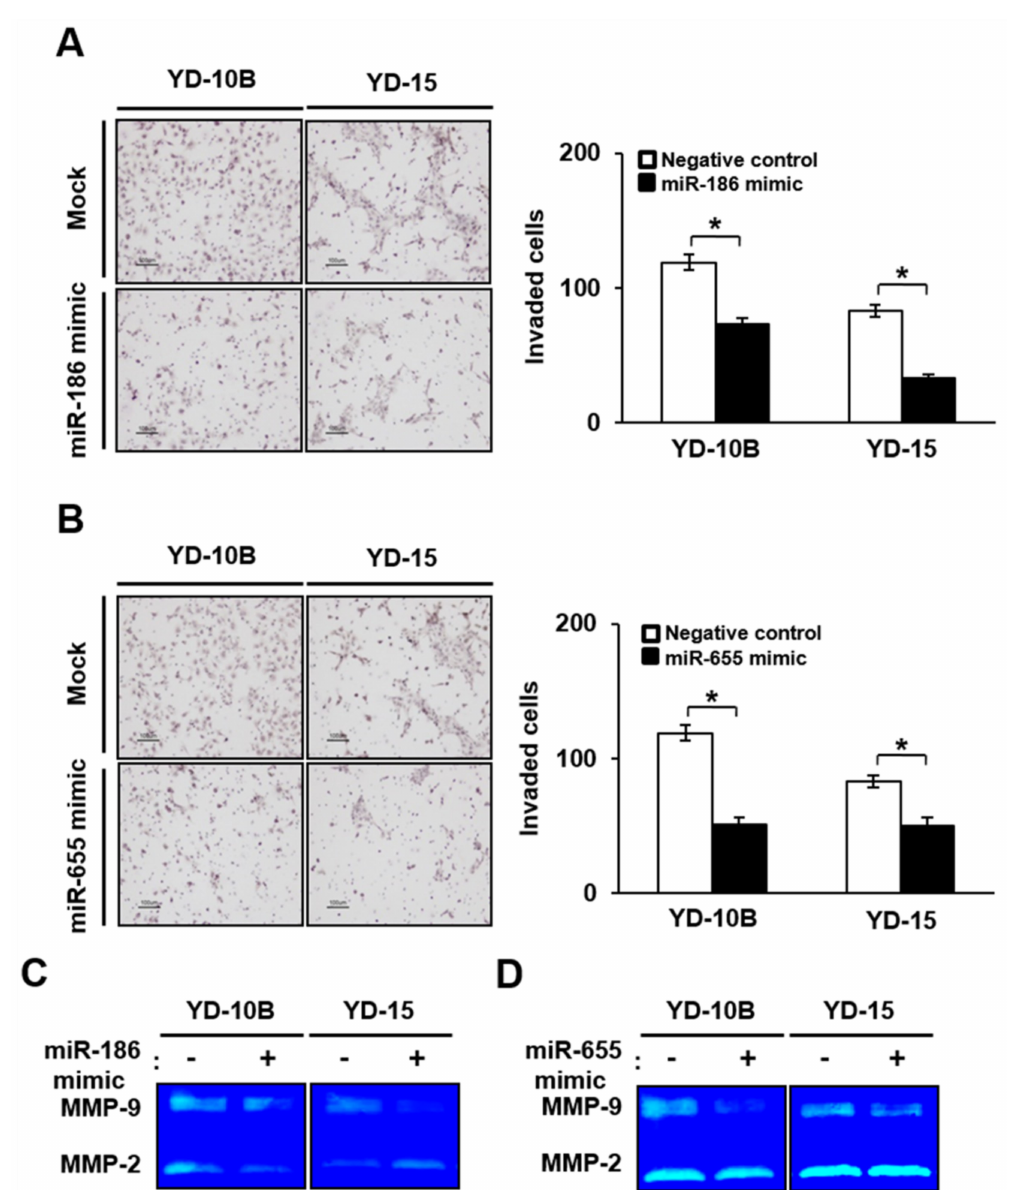
Figure 6. Effect of upregulated miR-186 and -655 on invasion abilities of oral SCCcell lines. Image (left) and numbers (right) of invaded YD-10B and YD-15 cells treated with ( A ) miR-186 and ( B ) miR-655 mimic sequences. Magnification, × 100; scale bar = 100 µ m. The values are means ± standard errors.* indicates significant differences between negative control and mimic treatment ( p < 0.05). All experiments were performed in triplicate. Activity of MMP-9 and -2 analyzed by zymography in YD-10B and YD-15 cells treated with ( C ) miR-186 and ( D ) miR-655 mimic